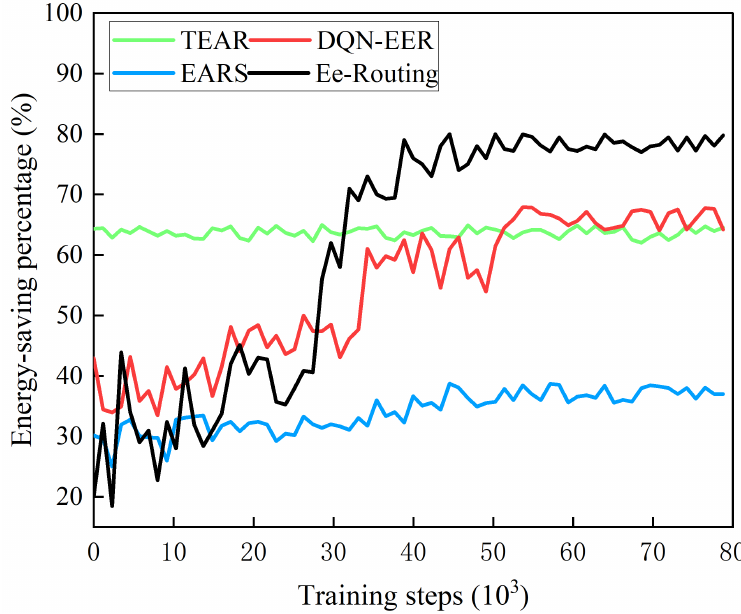
Figure 7. Energy-saving percentage under 60% traffic intensity.